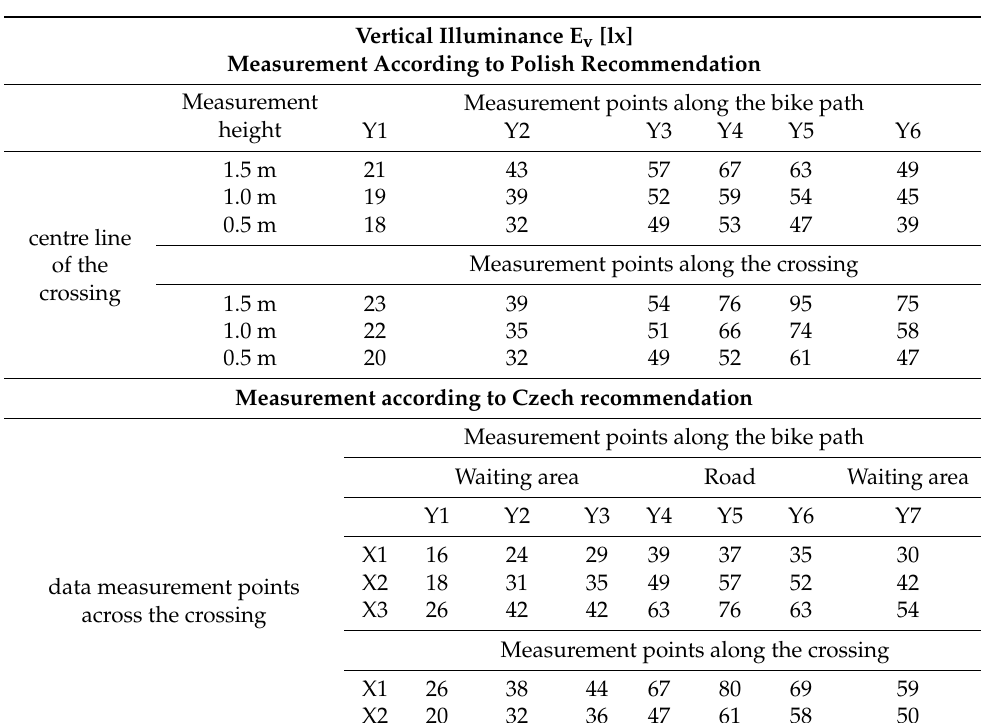
Table A4. Measurement results for the quality of illumination at pedestrian crossing no. 3 and cycle path—direction C.